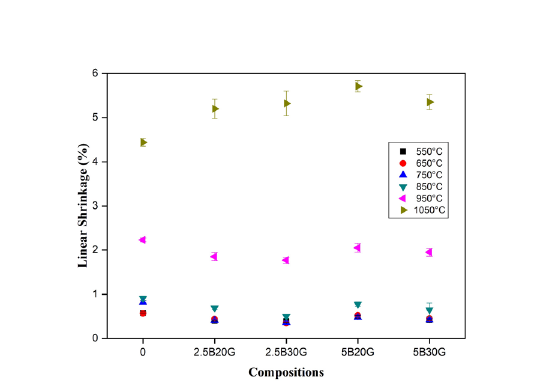
Figure 6. Linear shrinkage of compositions.